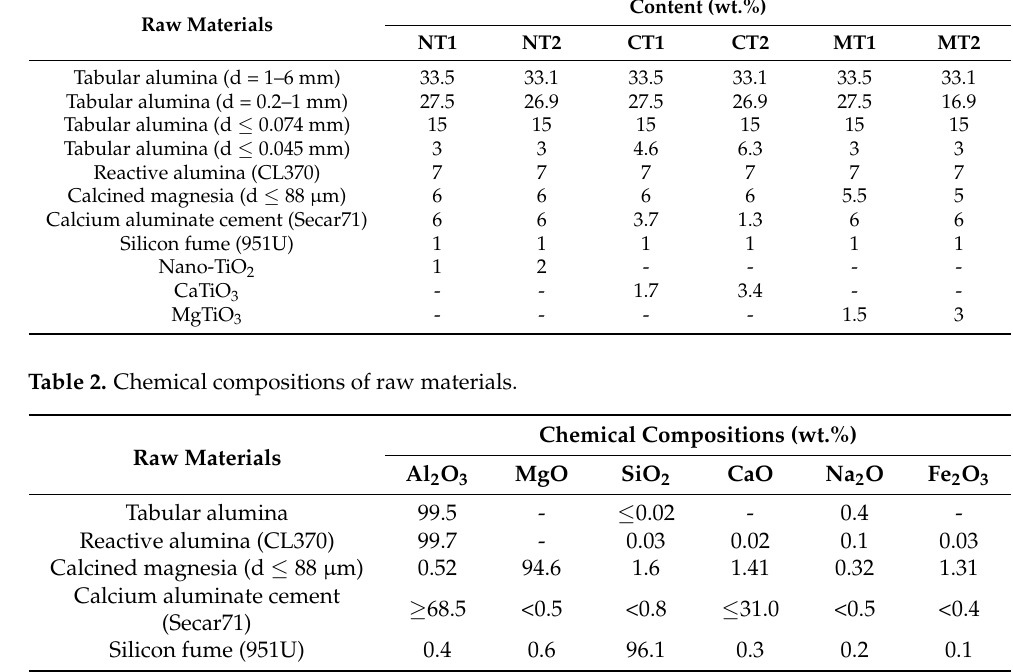
Table 1. Formulations of alumina-magnesia refractory castables. Raw Materials